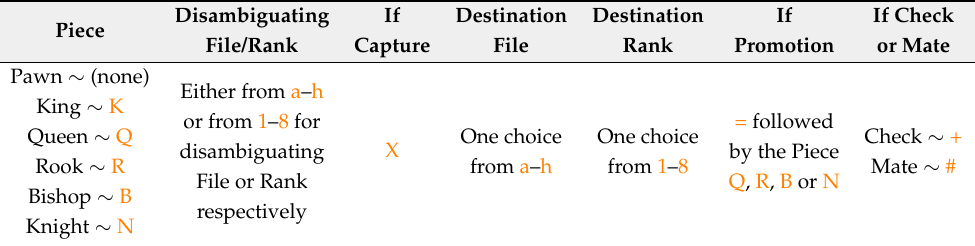
Table 1. Standard Algebraic Notation (SAN) for chess moves. Actual notations are shown in orange and the corresponding descriptions are shown in black. Short and long castles (not included in the table) are denoted by O-O and O-O-O respectively